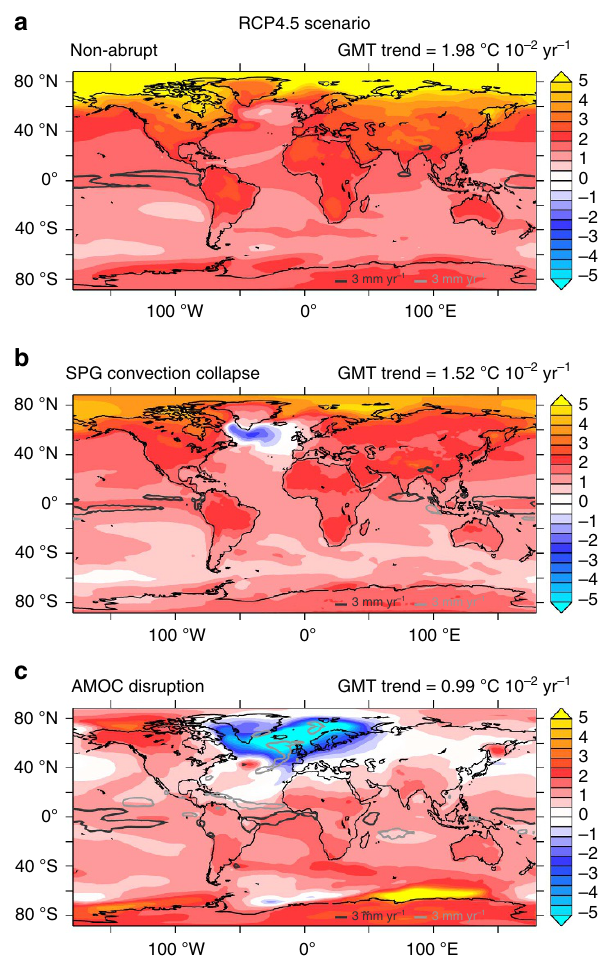
Figure 4 | Different climate impacts. Patterns of the 21st century SAT trend ( o C10 (cid:3) 2 year (cid:3) 1 ) under the RCP4.5 scenario for: ( a ) non-abrupt ensemble (27 members), ( b ) SPG convection collapse ensemble (7 members) and ( c ) AMOC disruption ensemble (2 members). The GMT trend is also displayed for each subset. The light grey and dark grey contours define regions where the ensemble mean precipitation trend, respectively, exceeds 300mm per century and is lower than (cid:3) 300 mm per century. Results for the RCP2.6 and RCP8.5 scenarios can be found in Supplementary Fig. 7 and Supplementary Fig.